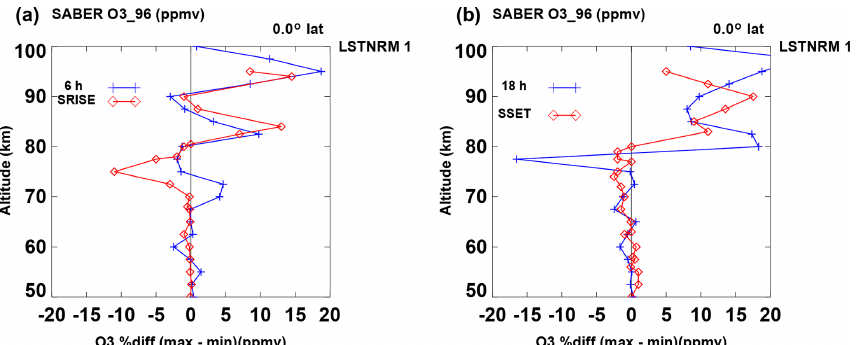
Figure 4. Ozone responses to solar activity versus altitude from 50 to 100km at the Equator. Values are responses at solar max minus responses at solar min (%/100sfu). Red diamonds denote results based on HALOE data from Beig et al. (2012) at 6LST (a) and 18LST (b) , composite from 0–4 ◦ N. Blue plusses denote our results based on SABER data at 6LST and 0 ◦ (a) and 18LST (b) .